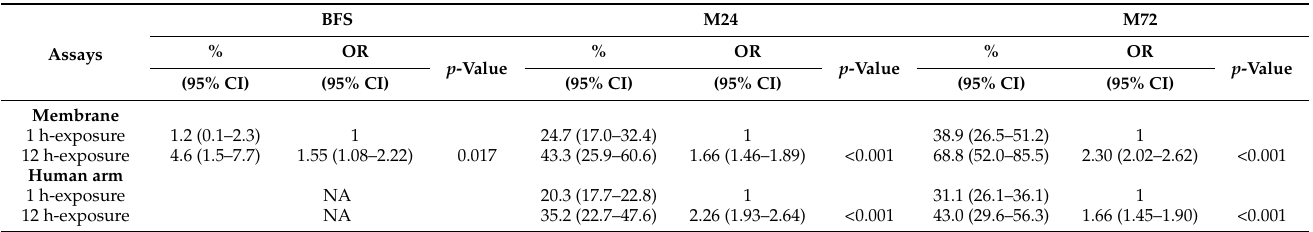
Table 3. Impact of exposure time on mortality and blood-feeding adjusted for the net condition; The difference in the odds of mosquito mortality at 24-h (M24) or 72-h (M72) and blood-feeding success (BFS)) for 100 pyrethroid-resistant Anopheles arabiensis exposed to Interceptor ® and Interceptor ® G2 with either a human arm or a membrane feeder as bait